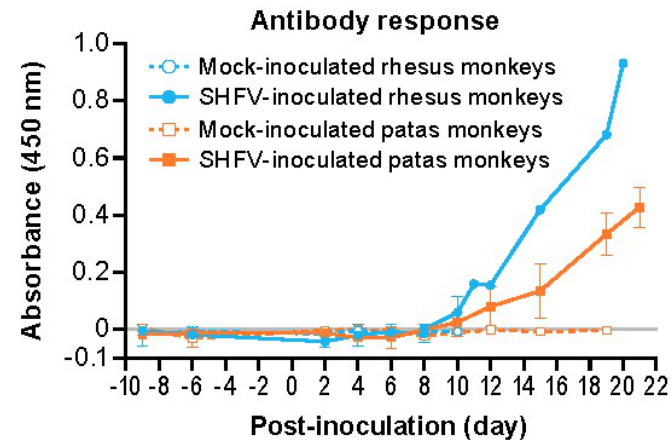
Figure 7. Mean ELISA absorbance values for patas monkeys (orange) and rhesus monkeys (blue) either inoculated with 5000 PFU of SHFV (open symbols) or with PBS (closed symbols). The error bars represent standard deviation.